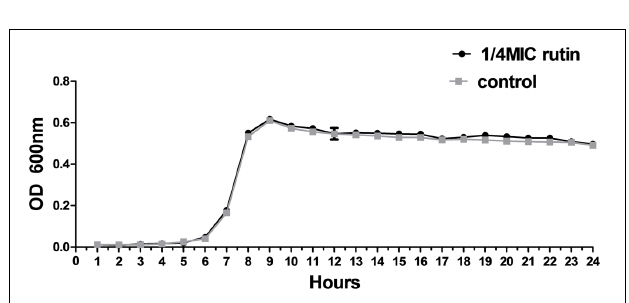
FIGURE 1 | Effect of rutin at different concentrations on Streptococcus suis biofilm formation. The data are expressed as the means ± standard deviations. Asterisk indicates statistically significant difference of treatment versus untreated culture ( ∗ p < 0.05).